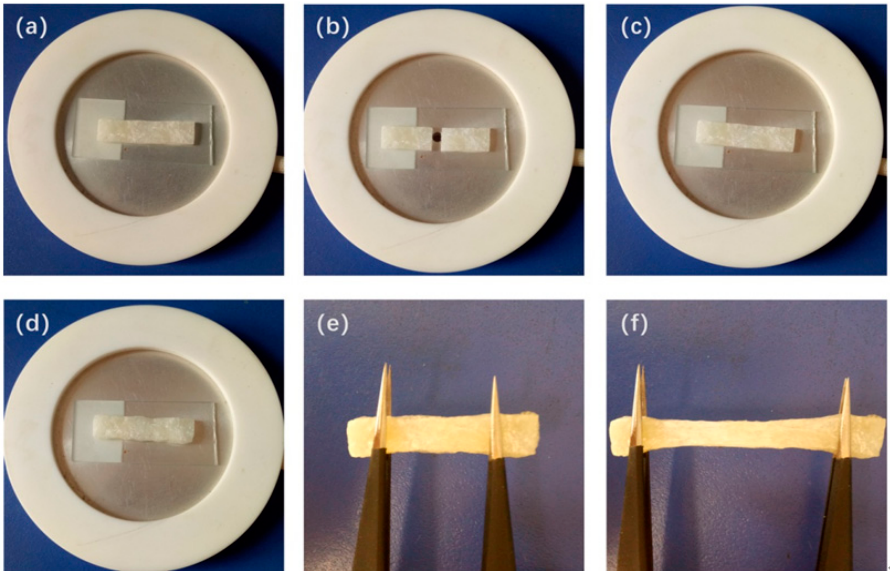
Figure 8. Self-healing process of PI-UPy observed by camera: ( a ) an initial elastomer sample; ( b ) the elastomer sample cut into two parts; ( c ) the separated two parts put together; ( d ) the elastomer sample heated on the hot-stage; ( e ) and ( f ) the healed elastomer sample stretched to show its strength.